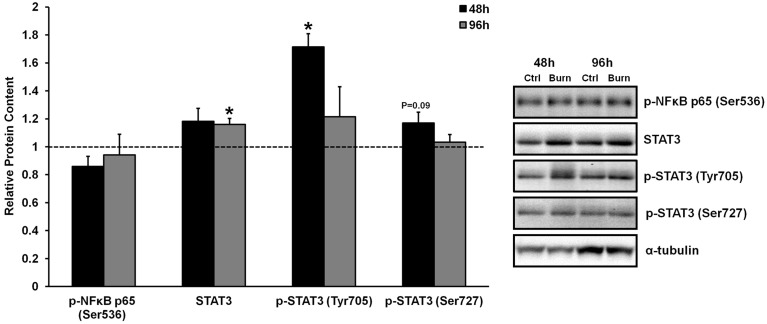
Effects of burn serum on inflammatory NF κB and STAT3 signaling. *Different from control at respective time point; P < 0.05. Dotted line represents control values. Representative blots for α-tubulin demonstrate equal loading between burn and control lanes.